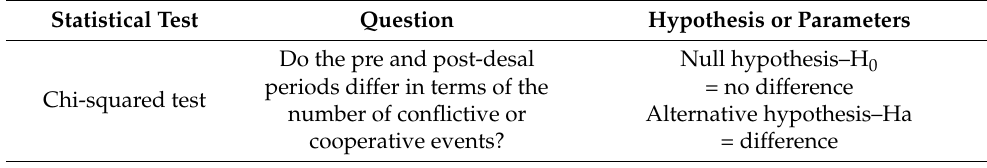
Table 1. Summary of the statistical tests